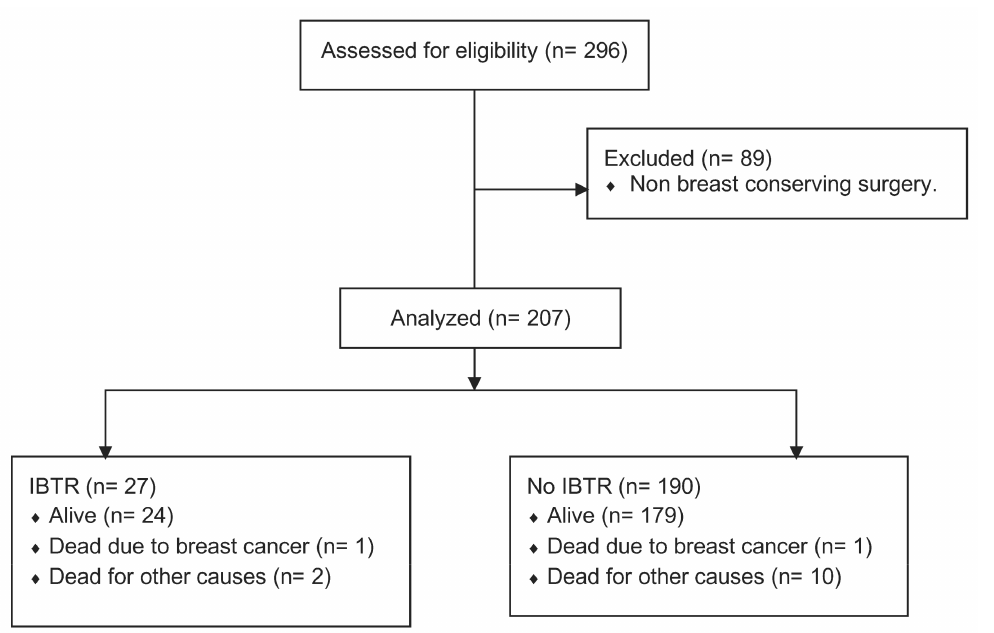
Figure 1. Historical cohort